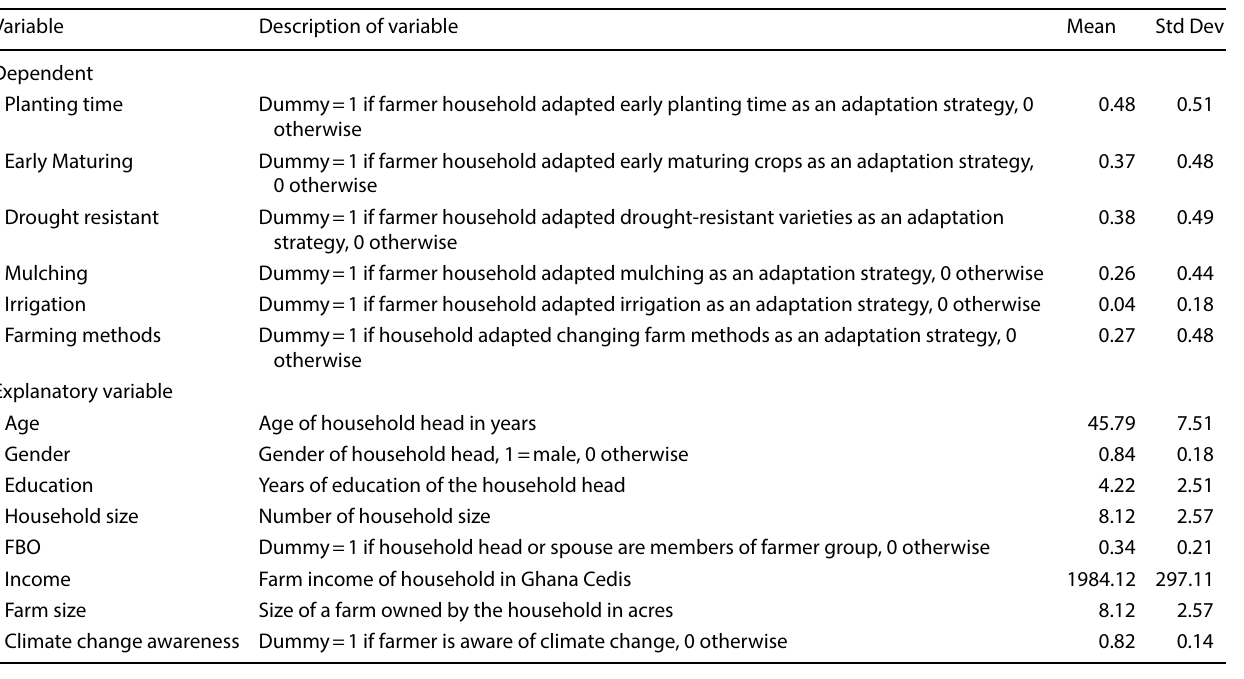
Table 5 Descriptive statistics of variables for the MV probit model